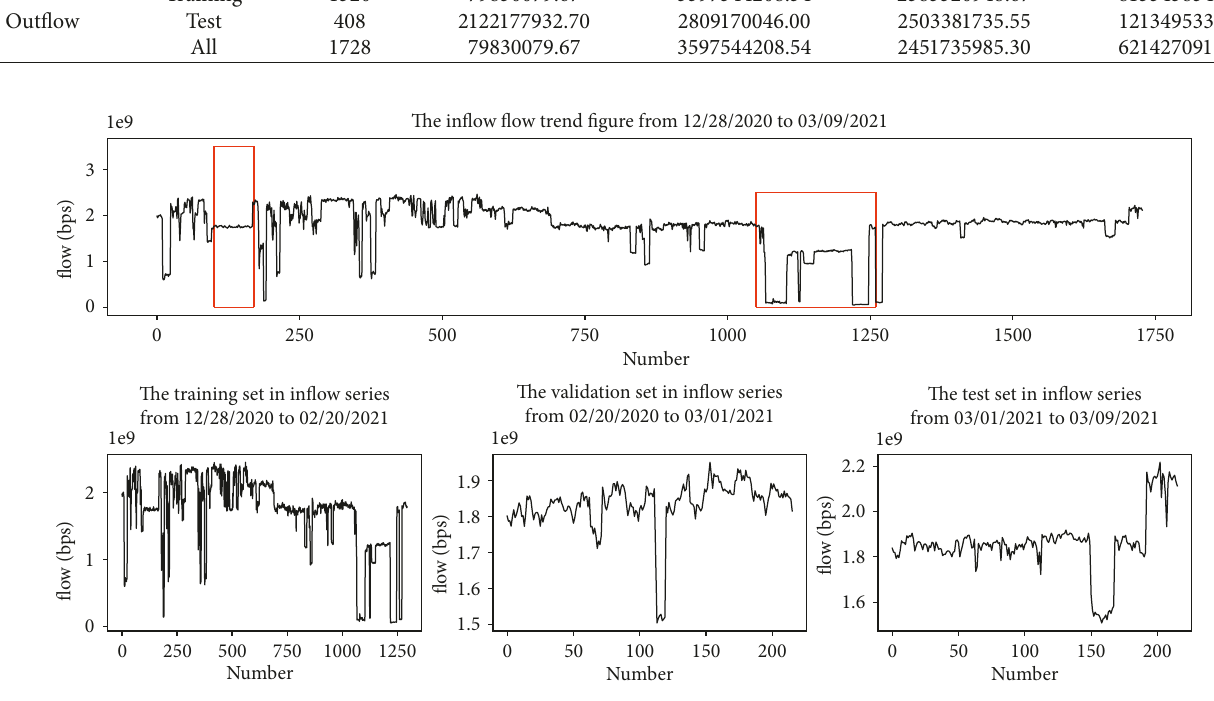
Figure 3: The investigated network inflow